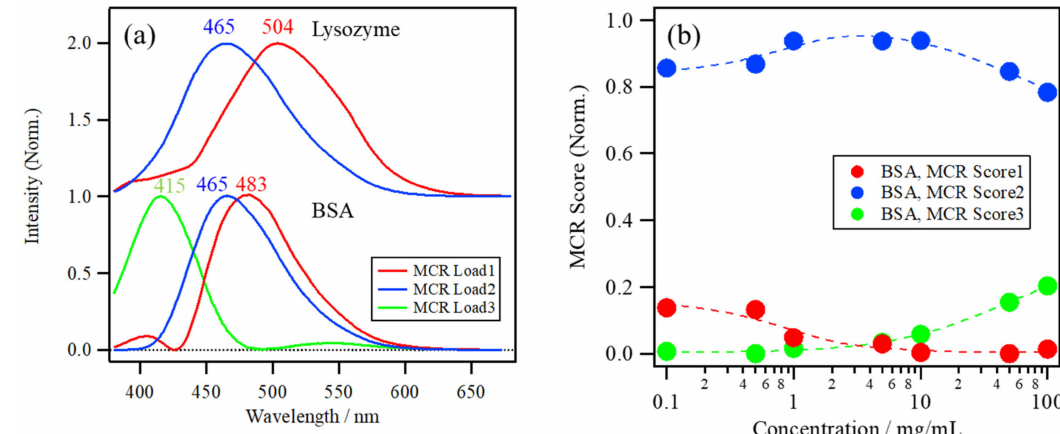
Figure 6. ( a ) The MCR loadings and ( b ) scores of the ANS fluorescence spectra of the BSA solution at pH 7.0, with those of the lysozyme solution at pH 8.0 as a